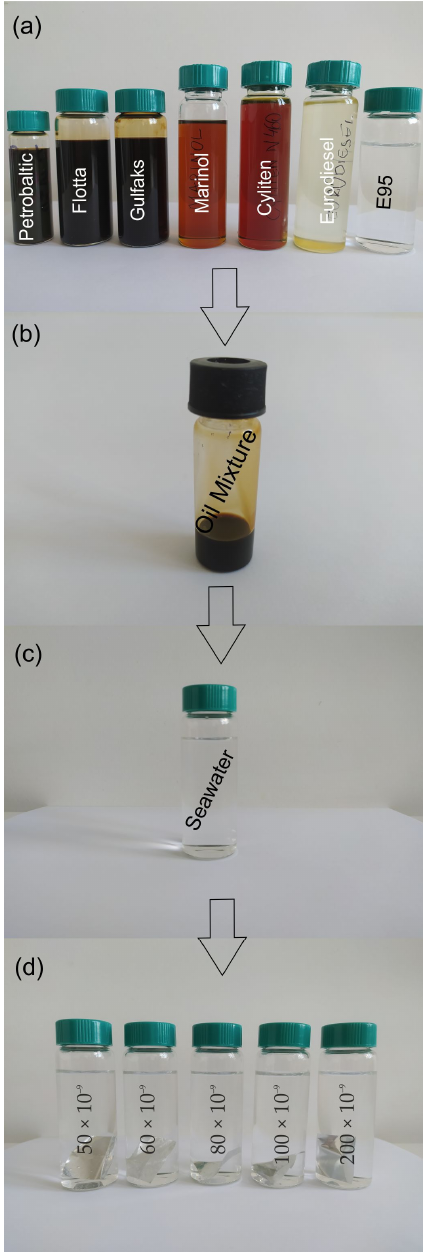
Figure 1. The steps of preparing seawater samples contaminated by a mixture of oils: ( a ) seven kinds of oils, ( b ) oil mixture, ( c ) seawater, ( d ) seawater samples contaminated by a mixture of oils.